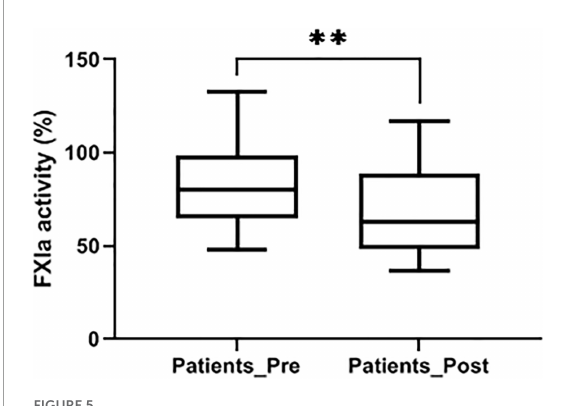
FIGURE5 FXI levels determined by a chromogenic method after full activation with kaolin in pre- and post-procedure samples. Values were represented as% of a reference pool of plasma from 100 healthy subjects. ** p <